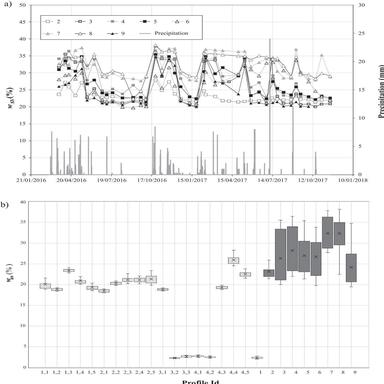
Evolution of wAV. (a) Variation of wAV in all PG3 profiles compared with precipitation. (b) For each profile, minimum value (lower horizontal line), first quartile and third quartile (coloured box: light grey, PG1; white, PG2; dark grey, PG3), mean (cross) and fourth quartile (top horizontal line) of the wAV values obtained during the 20 months analysed.